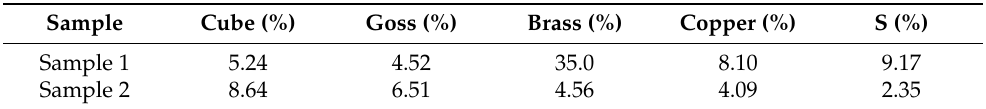
Figure 13. ODFs on the rolling plane of two T3-tempered samples: ( a ) sample 1; ( b ) sample 2. Table 5. Volume fractions of textures, calculated based on the ODFs of two T3-tempered samples (with a measurement accuracy of 0.05%).